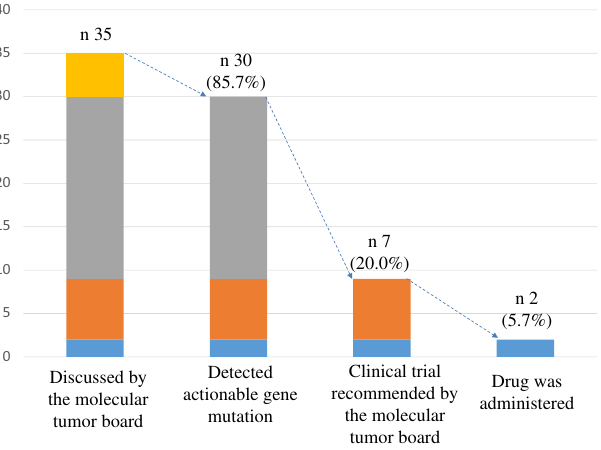
Figure 4. Drug accessibility rate. Drug accessibility status is shown. Of the 30 patients in whom actionable gene mutations were detected, only 2 patients (5.7%) received genome-matched treatment.